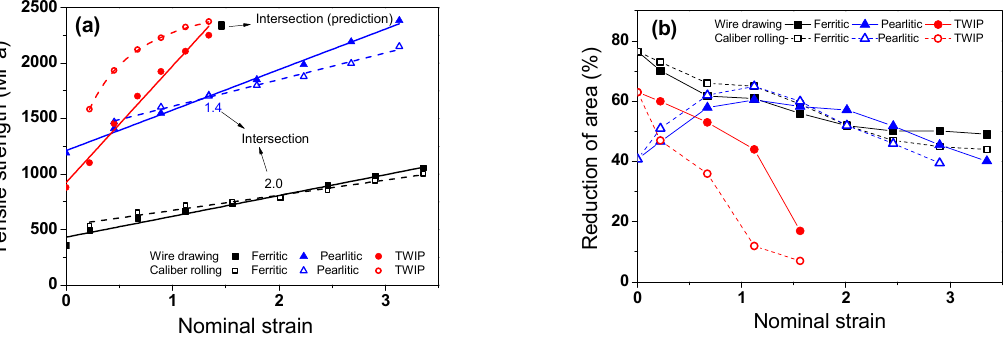
Figure 3. Comparison of the ( a ) TS and ( b ) RA of the three drawn and caliber-rolled steels with nominal strain.